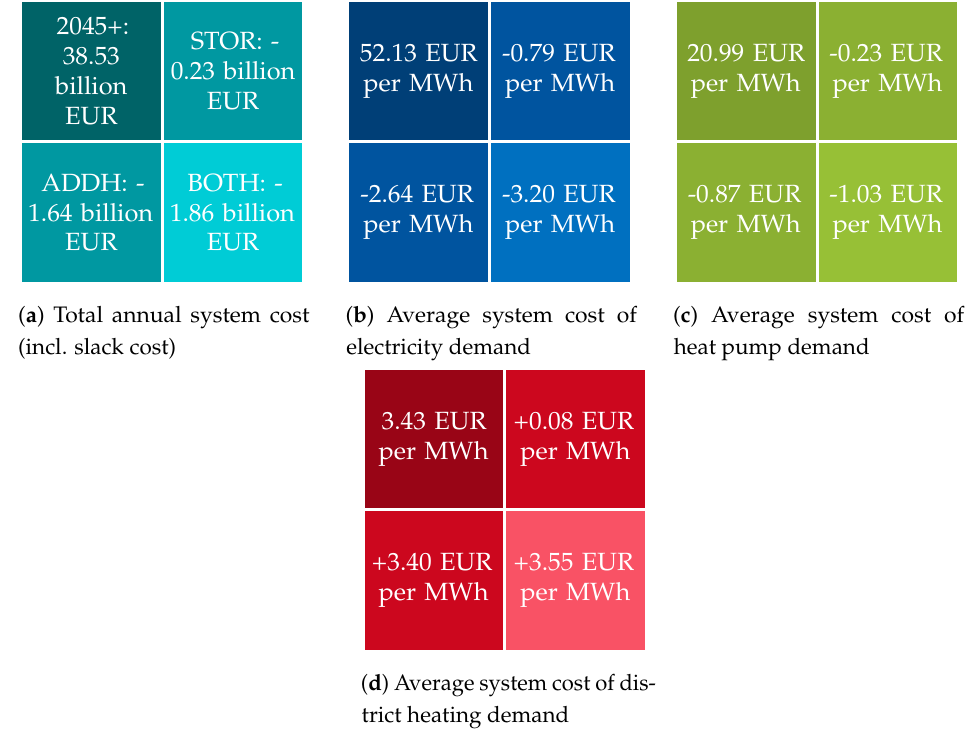
Figure 15. Overview of results from sensitivities. Results of the base scenario are provided as absolute values. The other values are given as deviation from the base